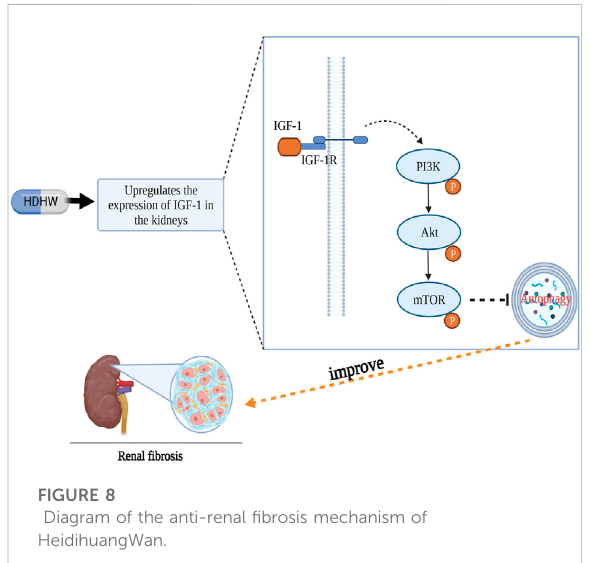
FIGURE 8 Diagram of the anti-renal fi brosis mechanism of